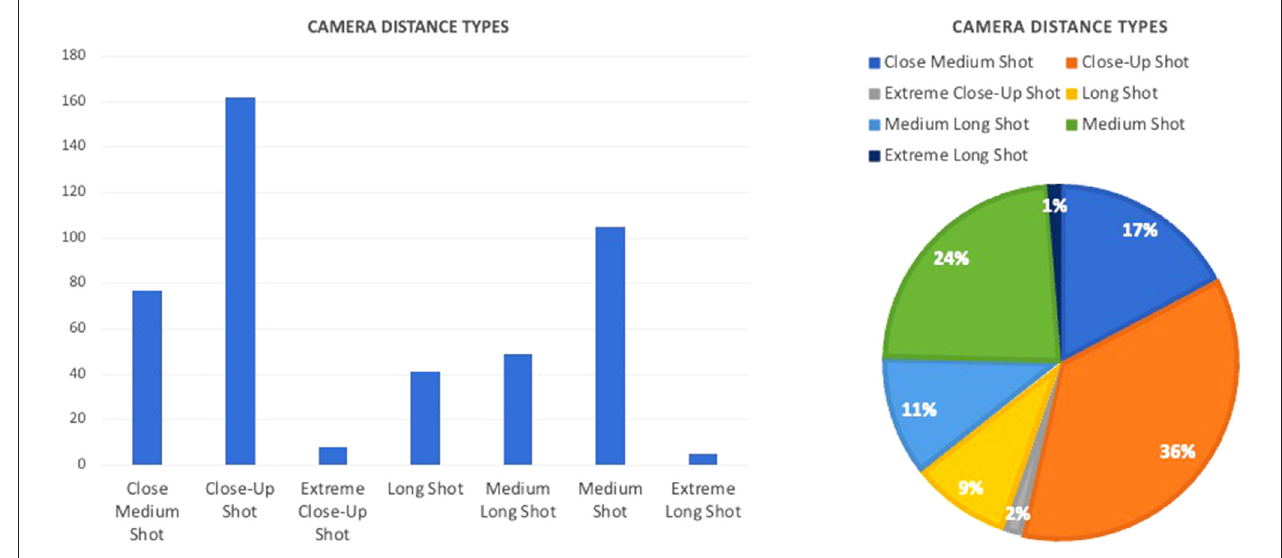
FIGURE 7 | Overview of camera distance types in all shots of the Heineken corpus.